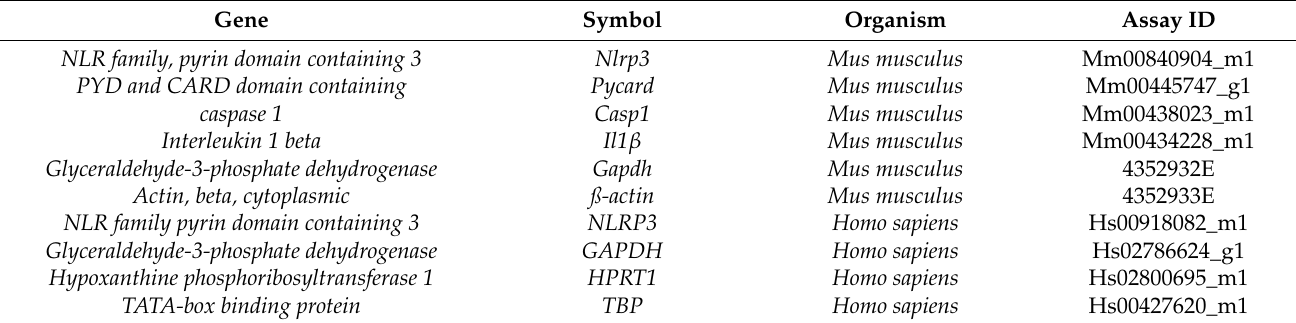
Table 2. Taqman ® Probe and Primer Mixtures Used in Gene Expression